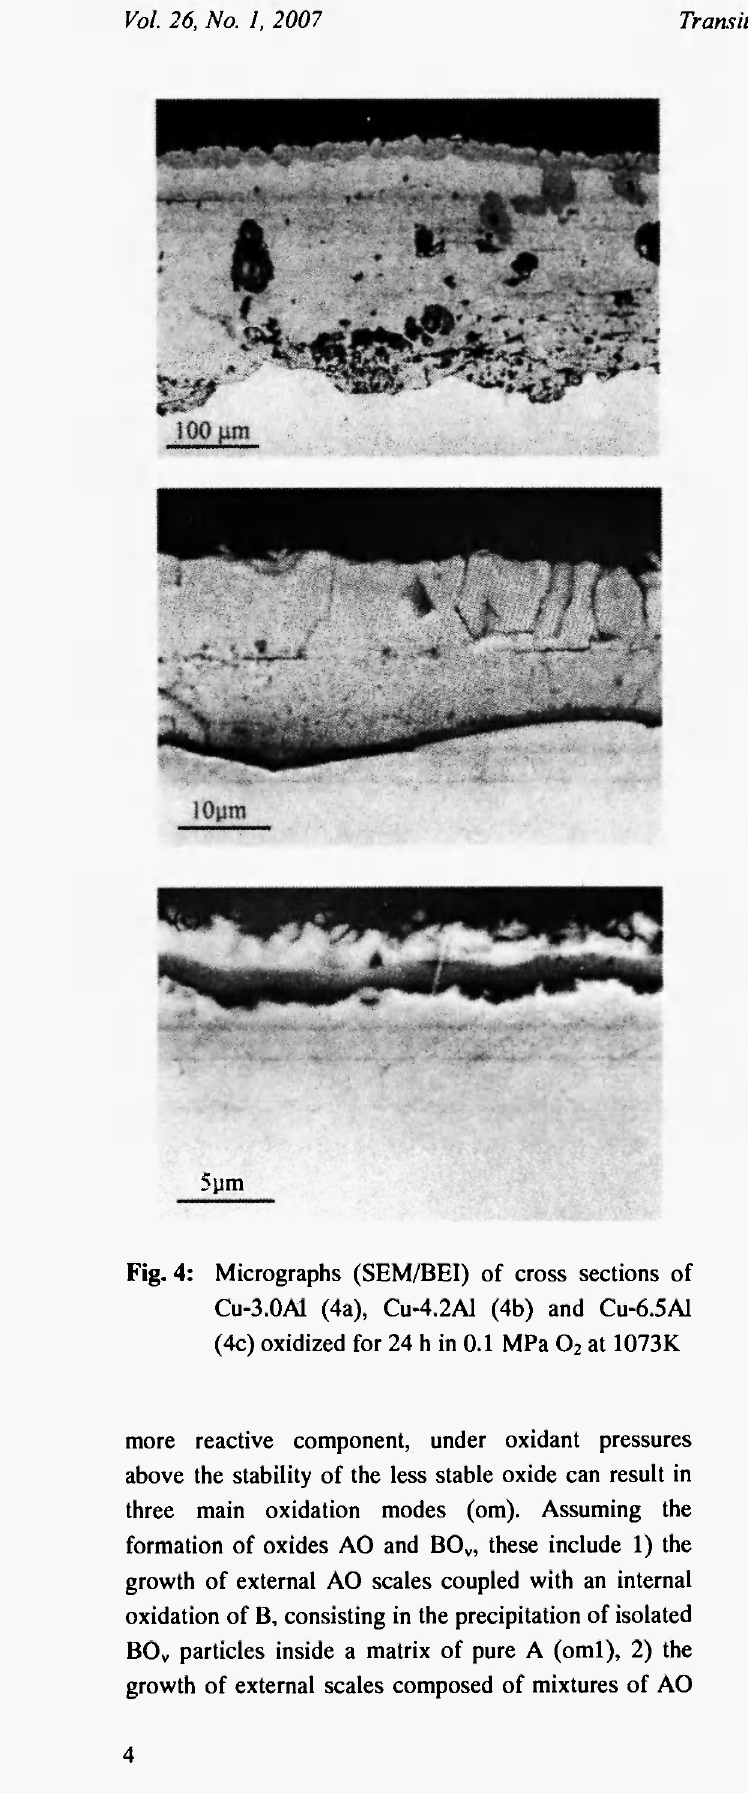
Fig. 4: Micrographs (SEM/BEI) of cross sections of Cu-3.0A1 (4a), Cu-4.2A1 (4b) and Cu-6.5A1 (4c) oxidized for 24 h in 0.1 MPa 0 2 at